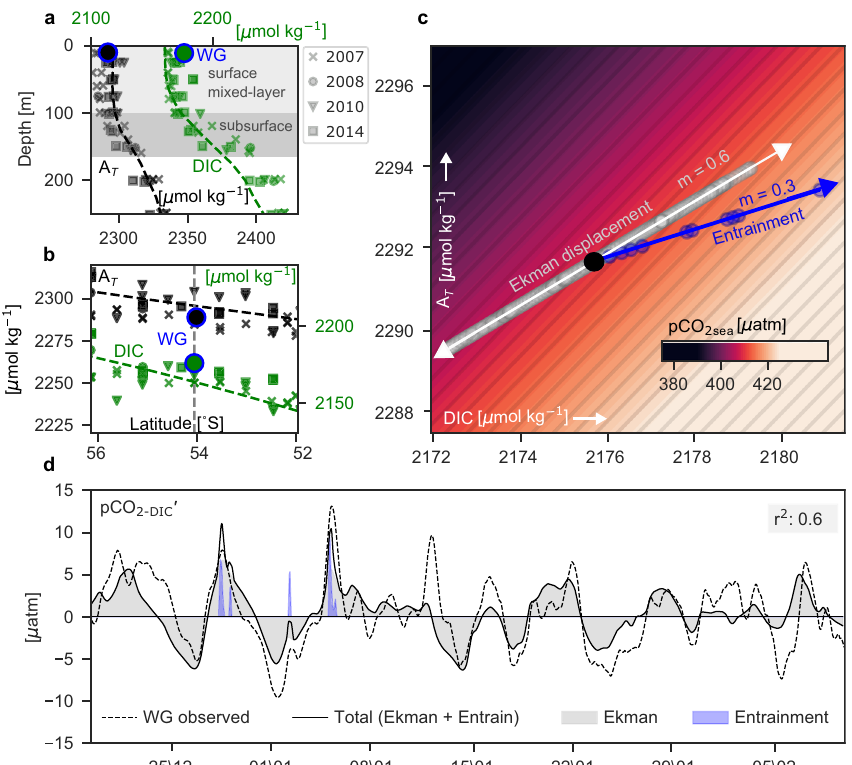
Fig. 3 Conceptual model to explain observed synoptic variability in pCO 2-DIC ′ . a Vertical pro fi les of total alkalinity (A T , black) and dissolved inorganic carbon (DIC, green) for different cruises at the location of the Wave Glider (WG) (54 ˚ S, 0 ˚ E) taken from GLODAPv2.2020 82, 83 . b Lateral distribution of surface A T and DIC from the same cruises. Shown on both a and b are the average A T and DIC from the WG observations (blue outlined circles) (see Methods) and from the summer (Dec – Feb) gridded climatology (dashed lines) 36, 37 . c The range of WG estimated observations of surface A T ( y -axis) vs DIC ( x -axis) with the partial pressure of CO 2 in the surface ocean (pCO 2sea ) as contours ( µ atm). Overlaid are the scatter plots of modelled lateral Ekman displacement of DIC vs A T , the modelled entrainment of DIC vs A T and the corresponding slopes (m) are shown, and the time-averaged A T and DIC value estimated from the WG (black circle). d The black line shows the model estimate of the synoptic variability of the non-thermal component of pCO 2 (pCO 2-DIC ′ ) through combined Ekman advection and entrainment. The dashed line is the actual WG observed pCO 2-DIC ′ . A rolling mean of the local inertial period is applied to both and their corresponding coef fi cient of determination (r 2 ) is shown. The grey shading shows the separate estimated contribution due to Ekman advection and the blue shading of entrainment to estimated pCO 2-DIC ′ .